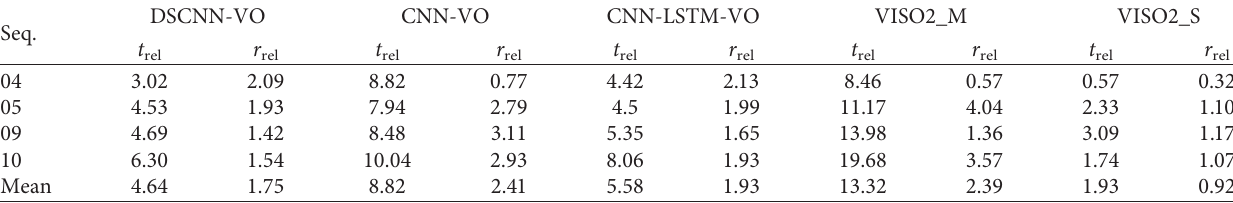
Table 2: Mean errors of each method on testing sequences.